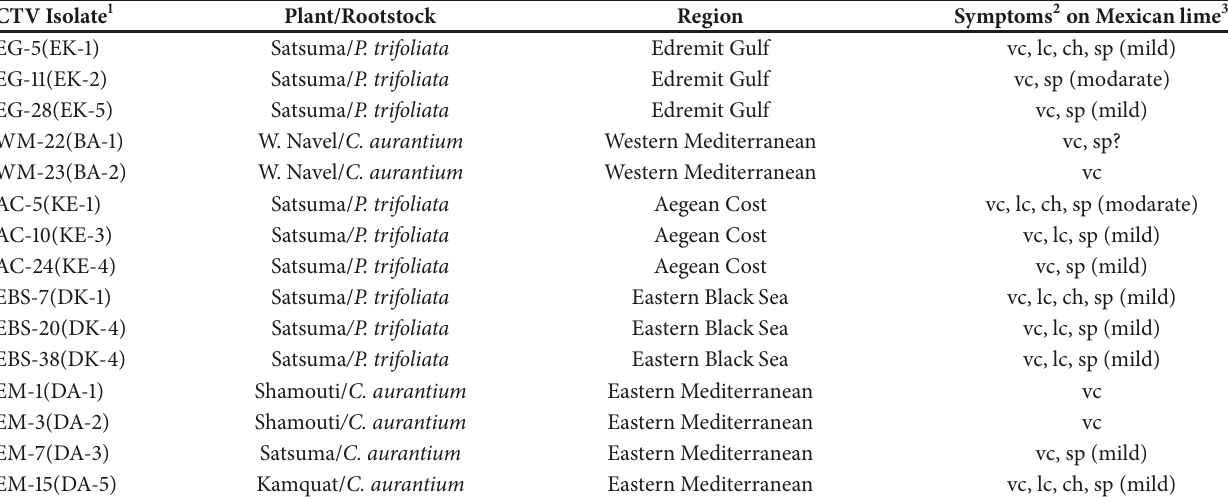
Table 1: Description of CTV isolates used for molecular characterization in this